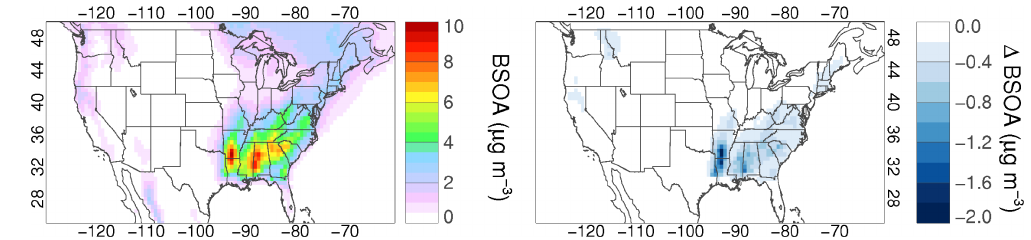
Figure 9. Left: mean JJA biogenic-SOA surface mass concentrations in the base scenario (Simulation 1). Right: the change in biogenic-SOA mass as a result of predicted tree mortality (Simulation 4 – Simulation